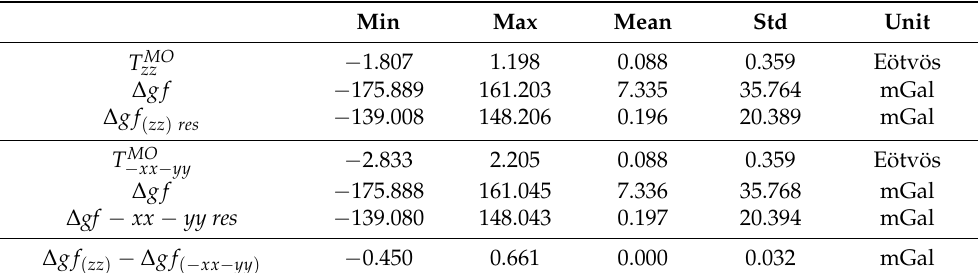
Figure 4. ( a ) The synthesized T MO − xx − yy at MO = 230 km, ( b ) the DC free-air gravity anomalies, ( c ) their residuals ( ∆ gf res ) with the ground data based on TIM_R6 d/o 300.